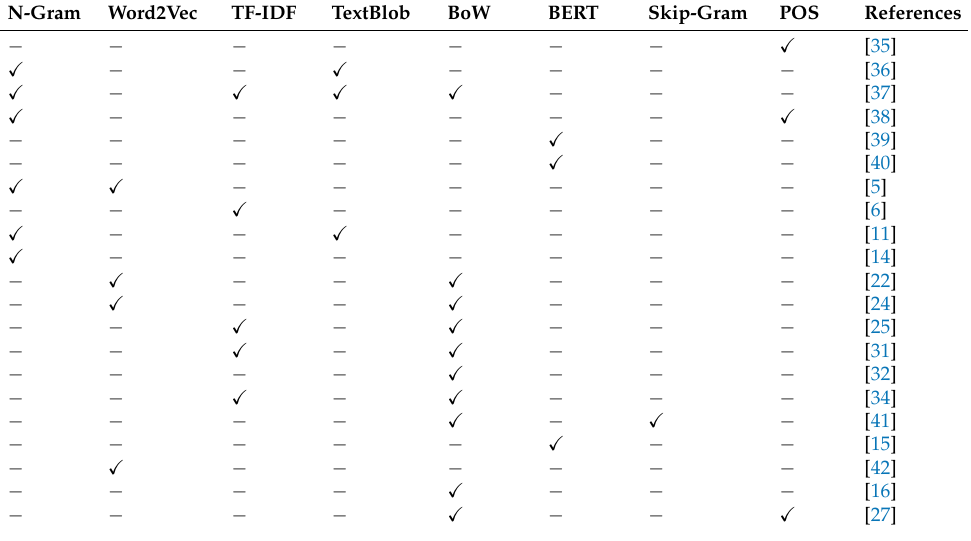
Table 1. Different text representation methods considered in various publications.